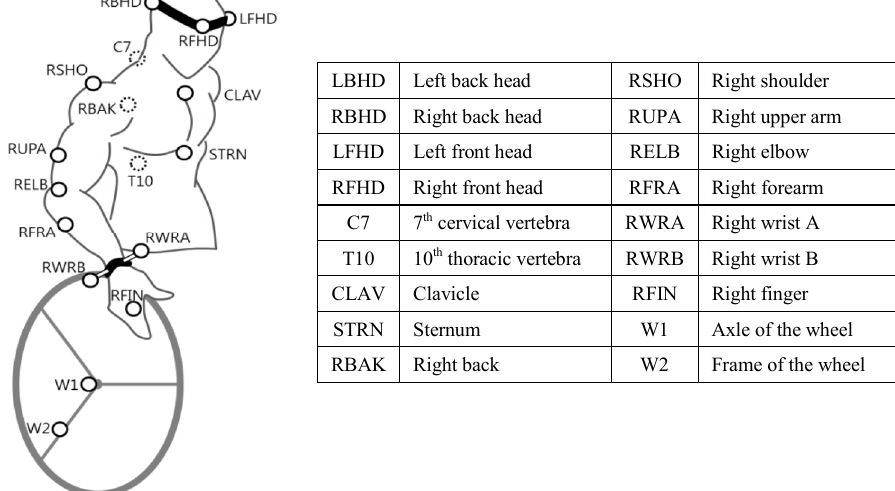
Figure 3. Reflective markers applied to subject and rear wheel of the